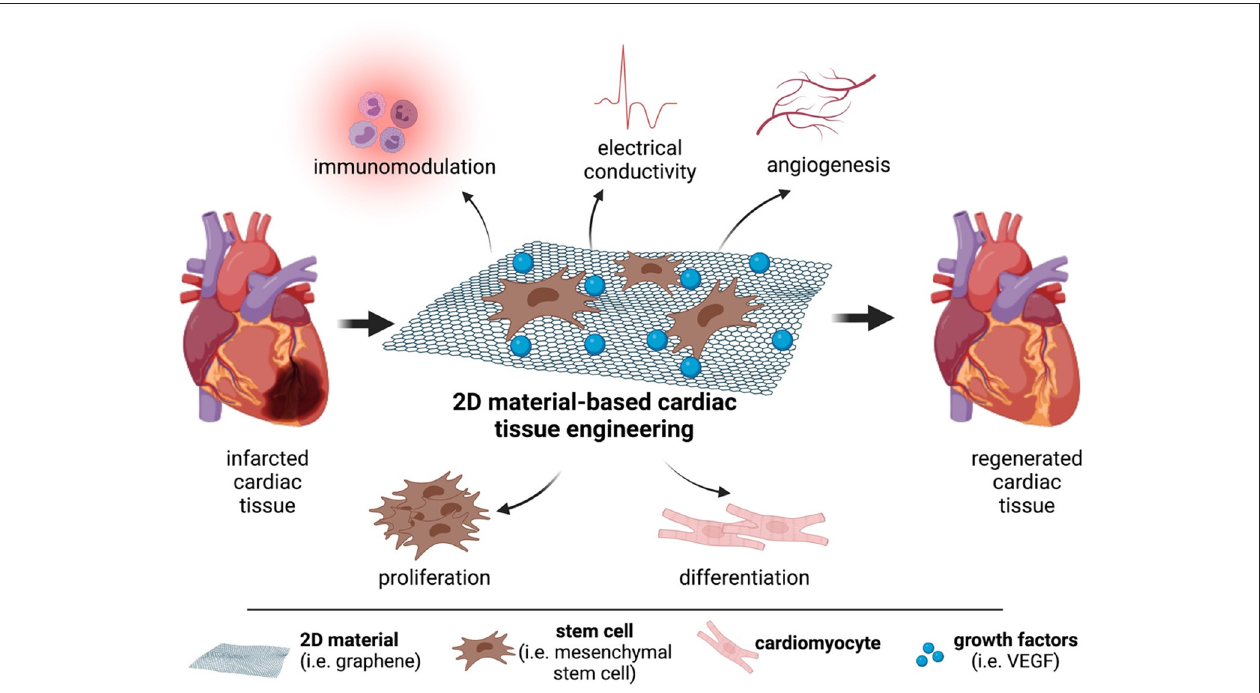
FIGURE 1 | The potential of 2D materials for cardiac repair and regeneration. Graphene or graphene derivatives can act as scaffolds for mesenchymal stem cells and deliver growth factors to the infarcted area. This strategy can allow the regeneration of the damaged cardiac